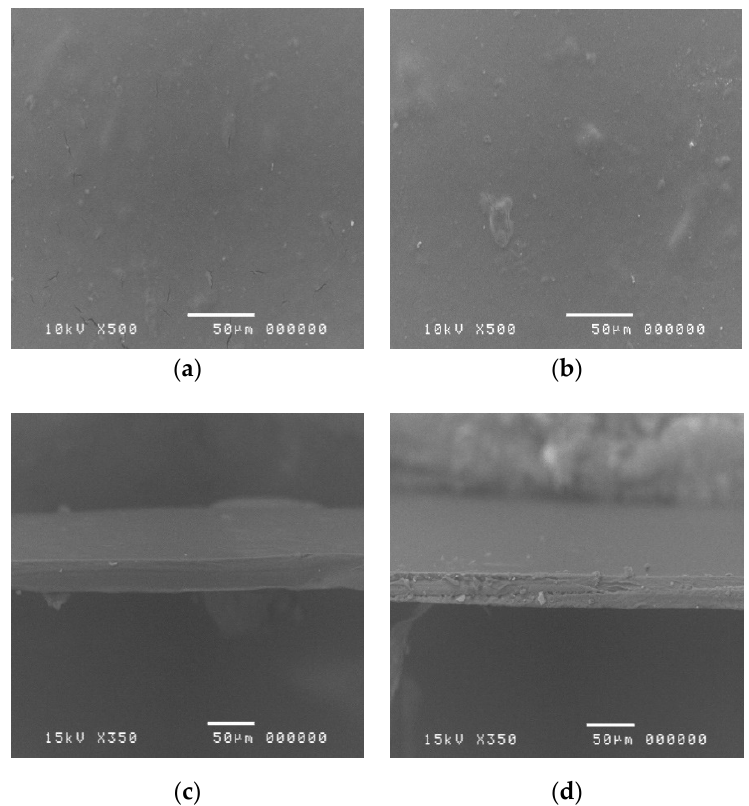
Figure 6. Scanning electron microscopy micrographs of the surface and crossection of cLMP and DP films at 500 and 340 magnification. ( a ) surface of a cLMP film; ( b ) surface of a DP film; ( c ) cross-section image of a cLMP film; ( d ) cross-sectional image of a DP film.